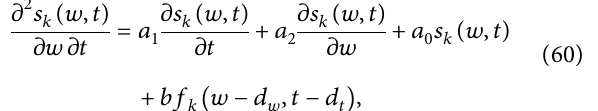
k with iteration number